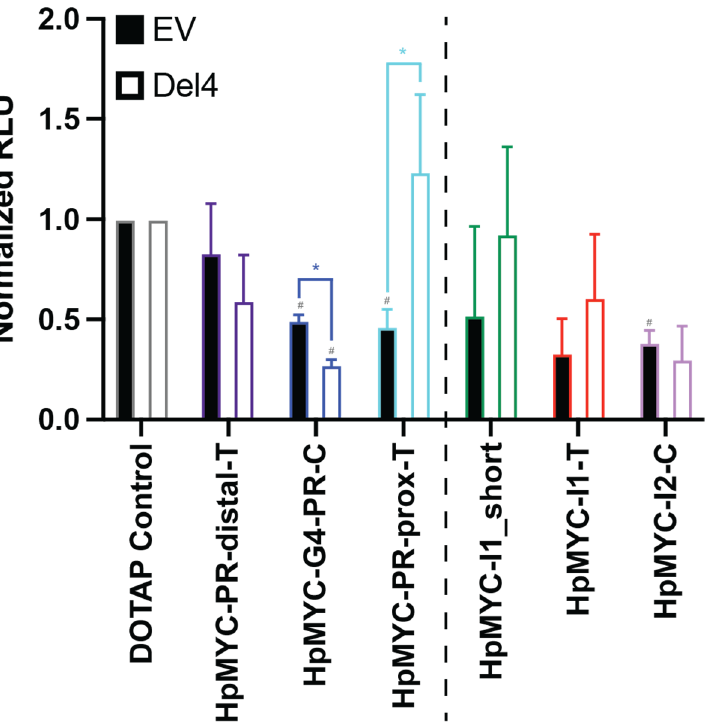
Figure 5. PPRH-mediated regulation of MYC promoter activity. Activity from the MYC promoter was measured indirectly via a luciferase assay using the Del4 luciferase plasmid, containing +/ − 400 bp around the transcriptional start site. HEK-293 cells were co-transfected with either the Del4 or a promoterless empty vector (EV) control and the pRL plasmid as a transfection efficiency control. The indicated PPRHs (1 µM; PR-distal-T, purple; G4-PR-C, blue; PR-prox-T, light blue; I1_short, green; I1-T, red; and I2-C, lilac) were co-transfected with the luciferase plasmid pairs; 48 h later, cells were lysed and luciferase activity was measured as a correlate to MYC promoter activity. For each plasmid:PPRH pair, effects were normalized to DOTAP vehicle control, and two-way ANOVA with Dunnett’s post hoc analysis was performed to determine statistical significance. PPRH targeting elements present in the Del4 plasmid are grouped to the left of the dashed line, and those targeting elements missing in the Del4 plasmid are grouped to the right of the promoter. HpMYC-G4-PR-C demonstrated a significant decrease in the promoter activity of Del4, compared to both its matched DOTAP control and its parallel EV:PPRH pair. Experiments were performed minimally in triplicate; # p < 0.05 as compared to plasmid matched DOTAP control; * p < 0.05 as compared to PPRH matched EV